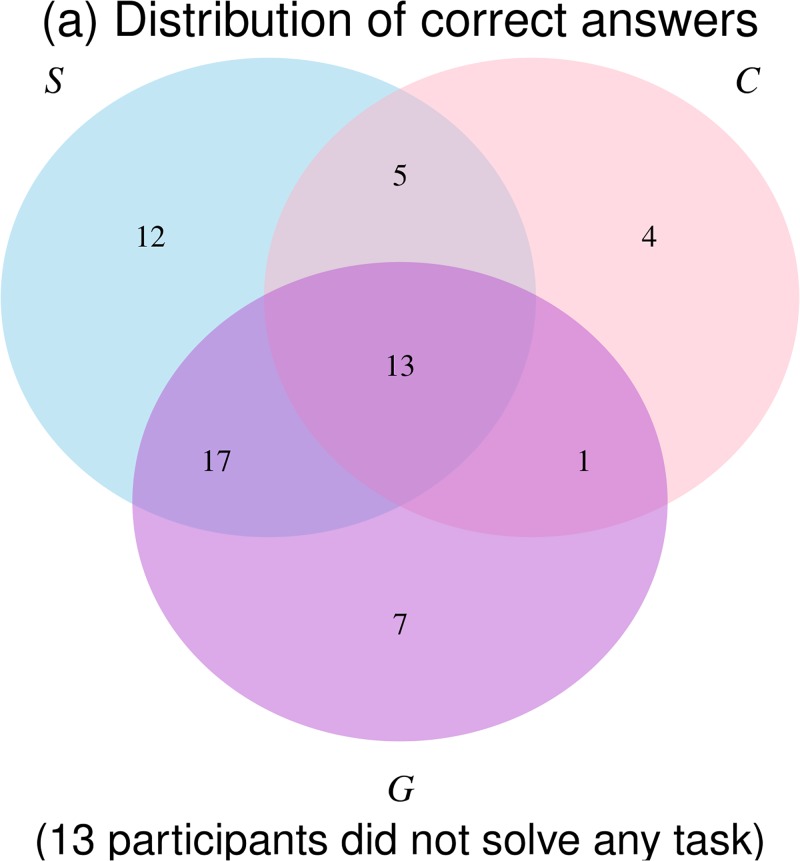
Strategic thinking tasks: Venn diagram showing the number of subjects who solved the different combinations of Simple (S), Complex (C) and Game (G).